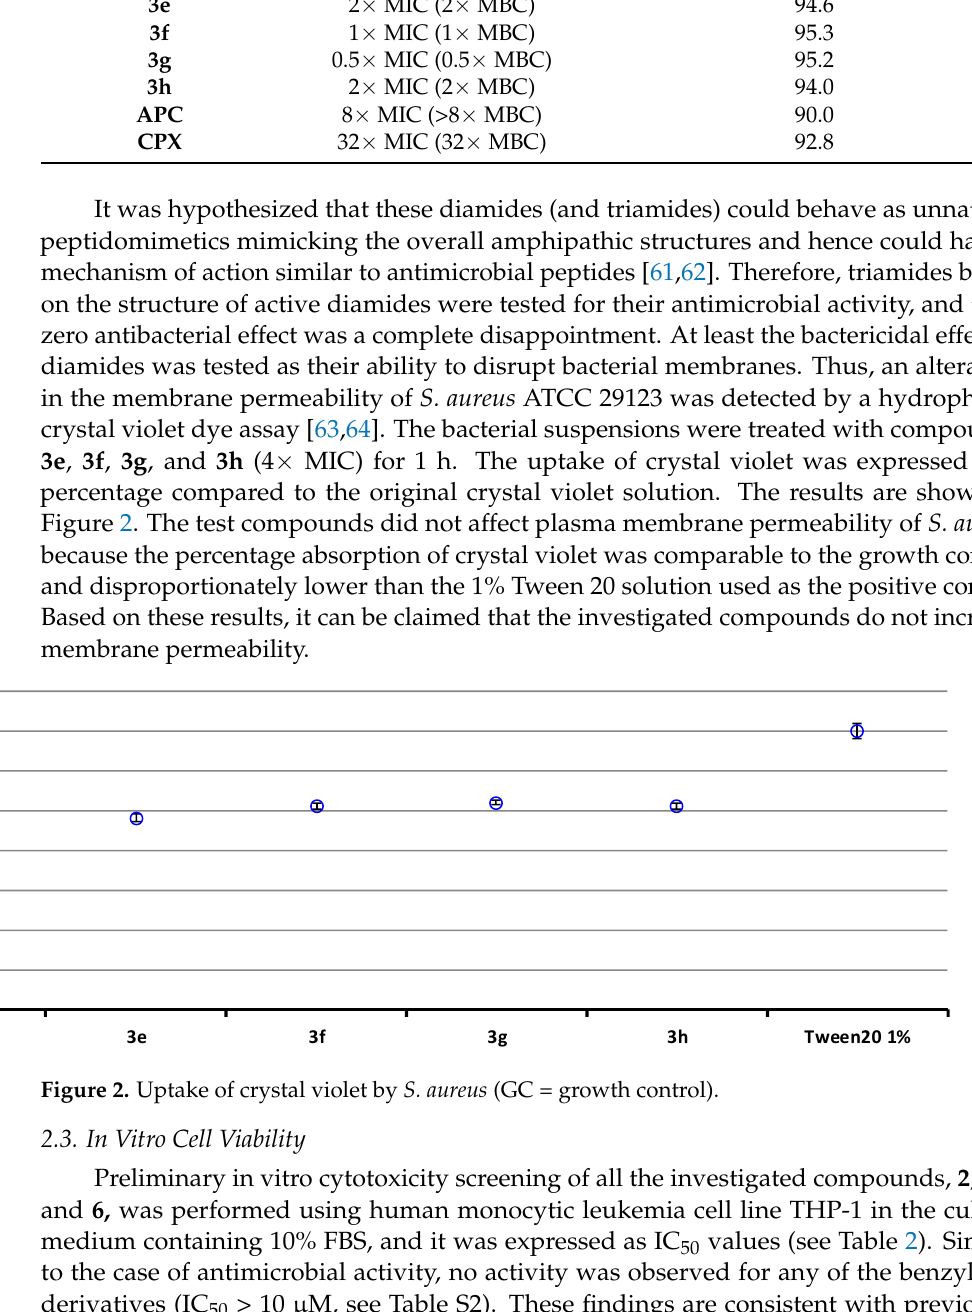
Table 3. Lowest MIC values with at least 70% inhibition of S. aureus ATCC 29213 viability. No.